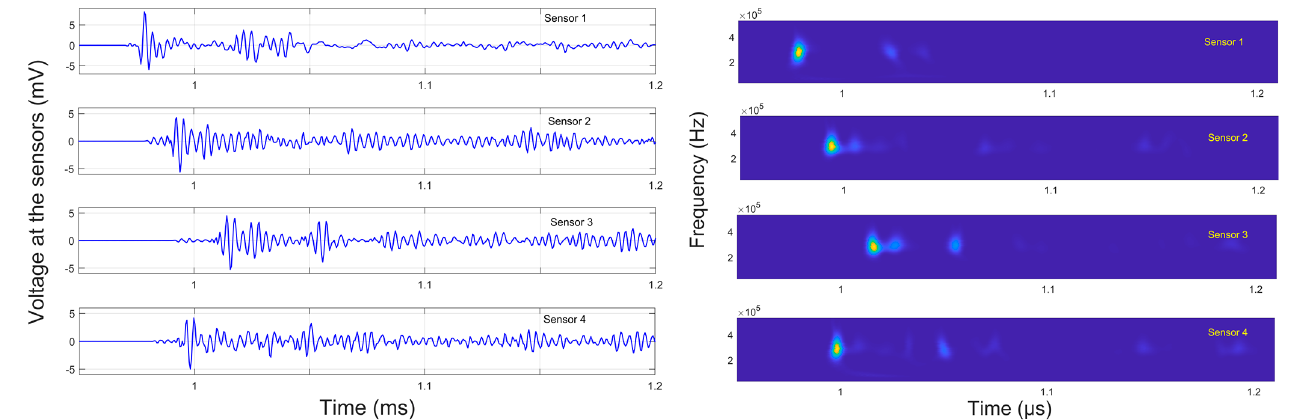
Figure 4. Time domain ( left ) and time–frequency domain ( right ) characteristics of the AE signals detected by sensors 1 to 4 when the source is located at PLB1 (15, 30).